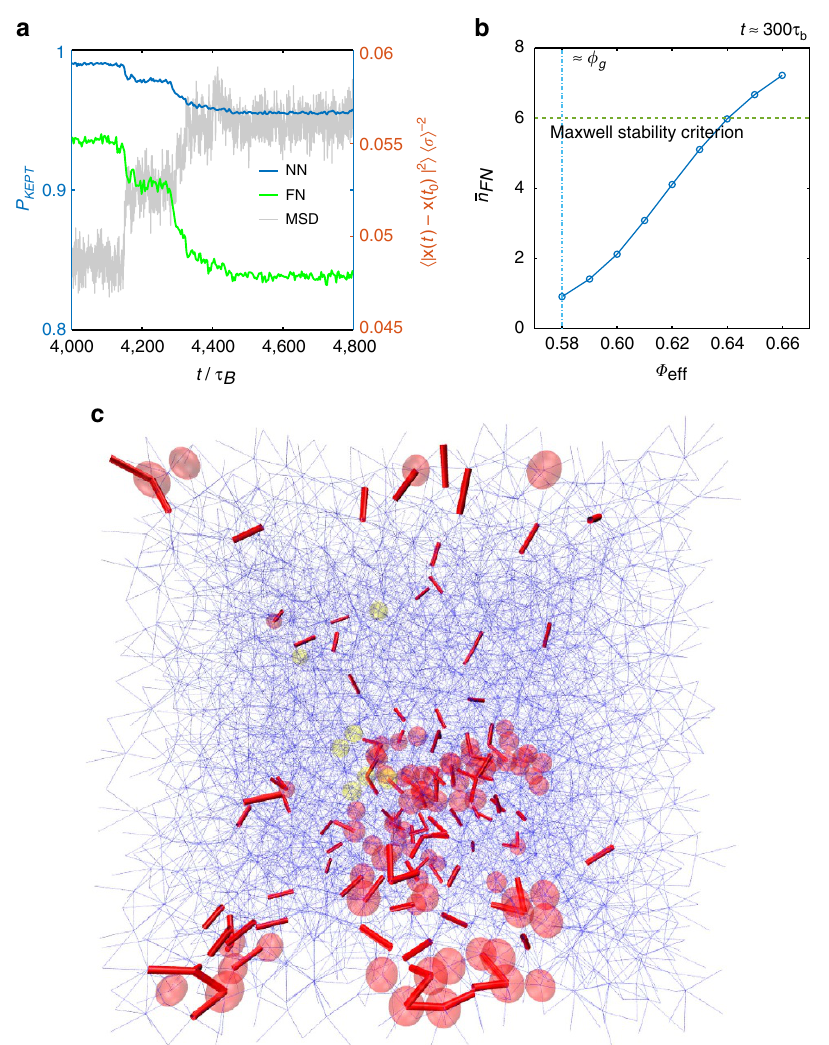
Figure 6 | Breakage of force chains. ( a ) The average proportion of neighbours kept by particles (left axis) compared to its neighbours at some initial time preceding an avalanche event in a polydisperse trajectory ( f ¼ 0.65). Results are shown for both nearest neighbours (NNs: blue curve) and force neighbours (FNs: green curve). The mean-squared displacement of the system is shown in the background by a grey curve (right axis): the re-arrangement of the system force network coincides with the avalanche. ( b ) The average number of FNs, (cid:2) n FN , observed after 300 t B at different volume fractions. ( c ) Re-arrangement of the force network during the avalanche event shown in a . Yellow and red particles are AIs and APs respectively, as in Fig. 5a,c. The stable force network that is not involved in the re-arrangement is shown by the blue network, whereas newly formed force bonds resulting from a re-arrangement since a time preceding the avalanche are shown as thick red bonds. We can see some correlation between APs and AIs and a significant local re-arrangement of FNs. This is a snapshot after an avalanche event; please see the Supplementary Movie to see the correlation over the course of the whole